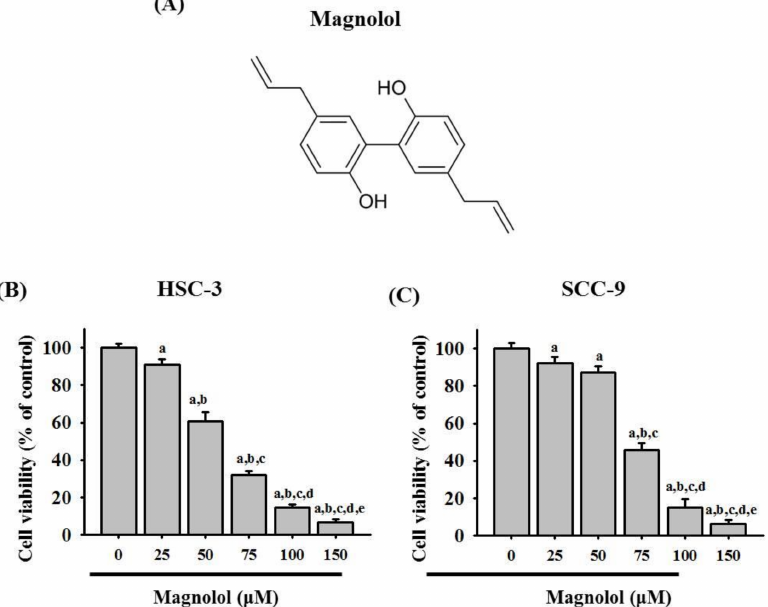
Figure 1. Magnolol inhibited cell viability in HSC-3 and SCC-9 oral cancer cell lines. ( A ) The structure of magnolol. ( B , C ) After treatment with magnolol (0, 25, 50, 75, 100, and 150 µ M) for 24 h, the cell viability of HSC-3 and SCC-9 cells was detected by using an MTT assay. The data represent the mean ± SD of three independent experiments. a Significantly different, p < 0.05, when compared to control. b Significantly different, p < 0.05, when compared to 25 µ M. c Significantly different, p < 0.05, when compared to 50 µ M. d Significantly different, p < 0.05, when compared to 75 µ M. e Significantly different, p < 0.05, when compared to 100 µ